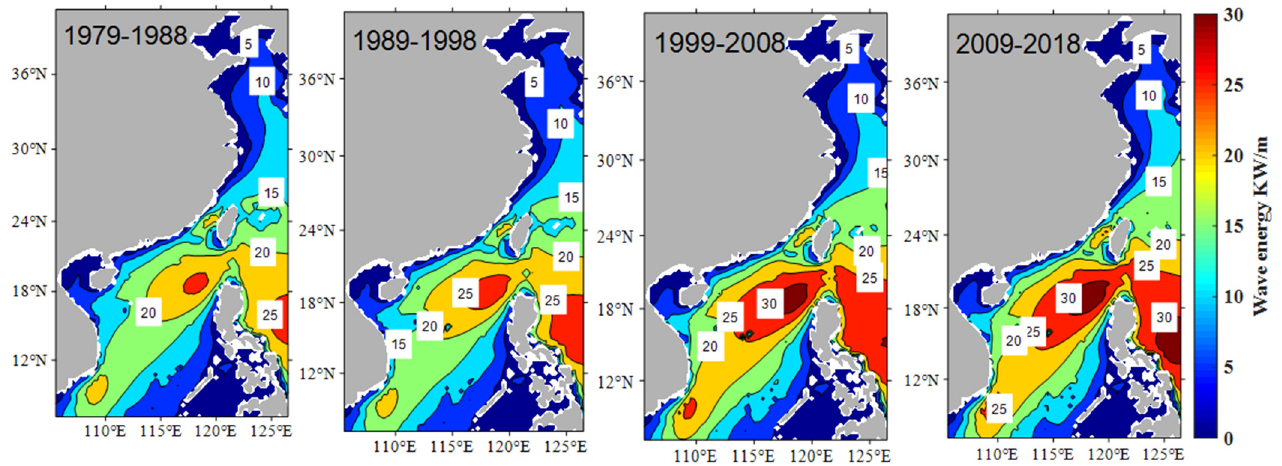
Figure 8. The decade distribution of P w in autumn.